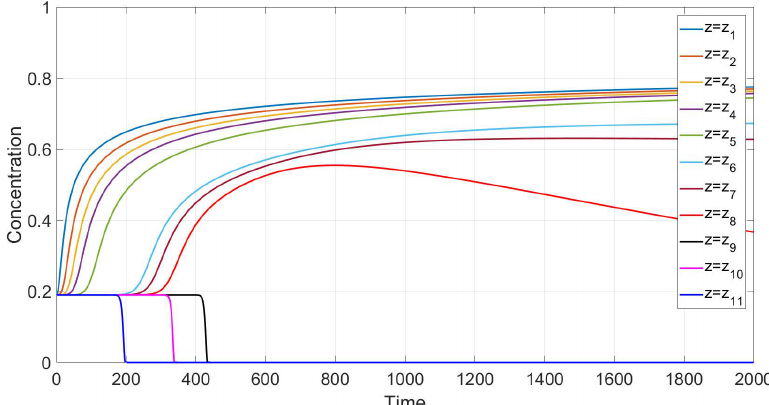
Figure 16. Calculated values of concentration versus time at different vertical locations for the flux F rz . Loss of monotonicity with the initial and boundary data c 0 = 0.19, c bot = 1, c top =